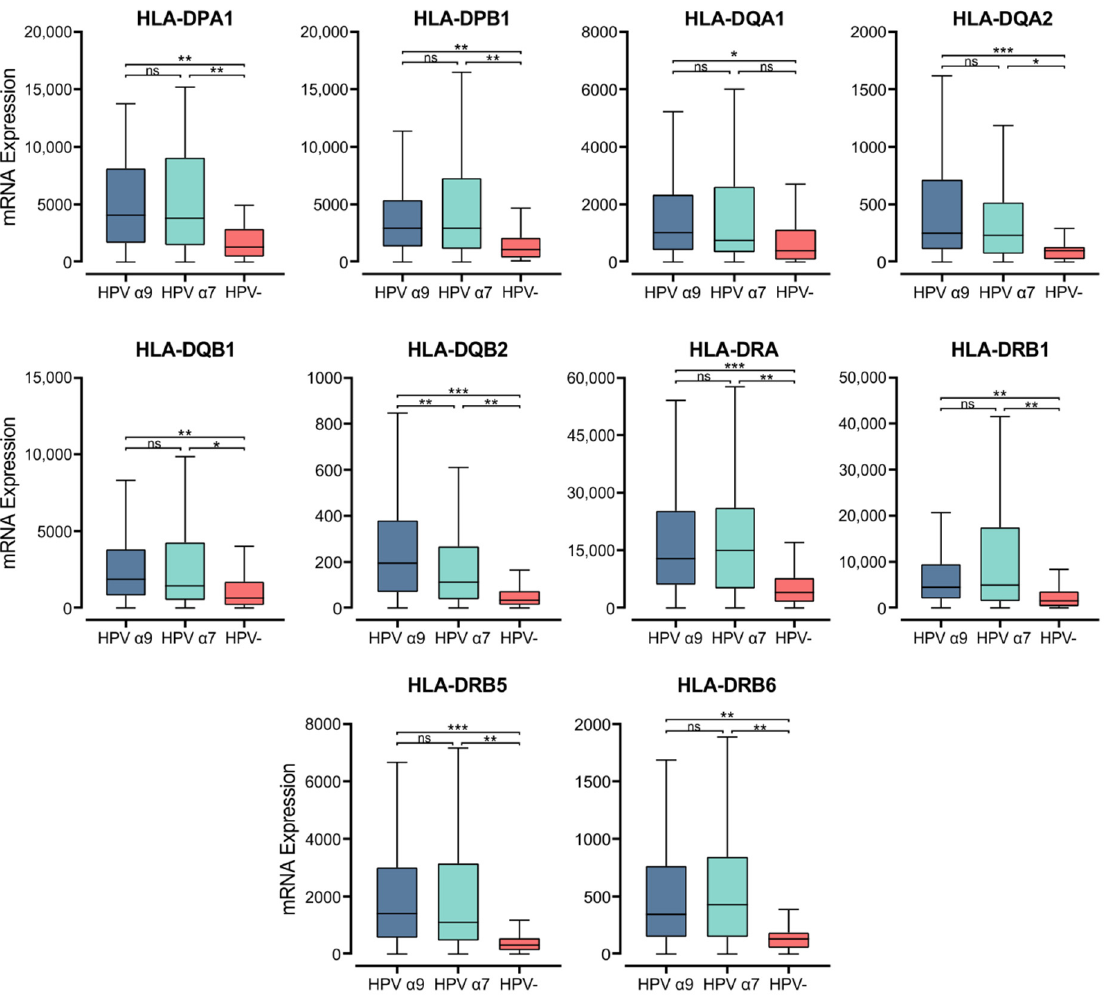
Figure 1. Expression of classical MHC class II α - and β -chain genes in CC stratified by HPV+ ( α 9 or α 7) and HPV − status. Normalized RNA-seq data were extracted from the CC cohort of the TCGA database. *** p ≤ 0.001, ** p ≤ 0.01, * p ≤ 0.05, ns (not significant).